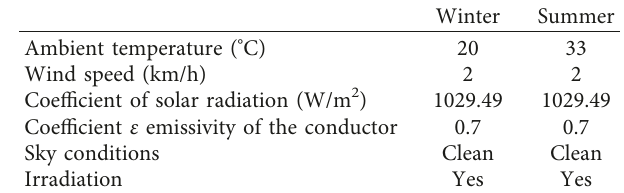
Table 2: East Sicily ambient conditions.